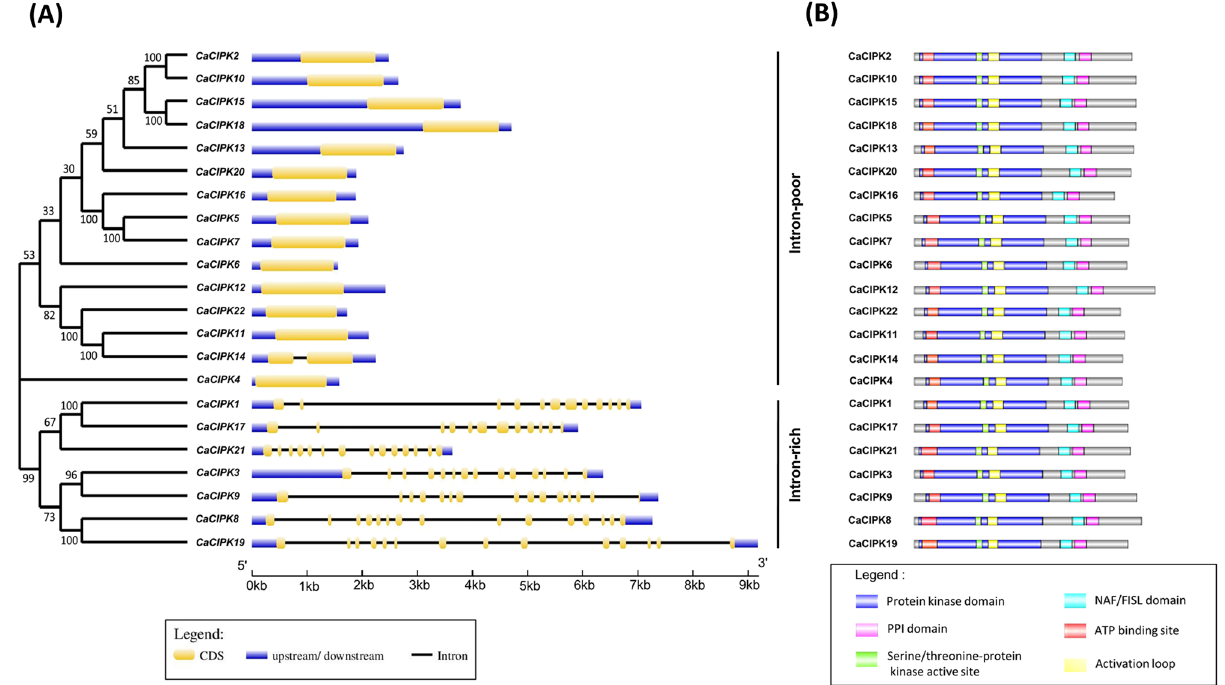
Figure 1. Structural features of chickpea CIPK family. ( A ) Exon–intron organization is shown for 22 CaCIPK genes. The gene structure was drawn using GSDS program. The yellow boxes represent exons, the lines represent introns and the blue boxes represent upstream/downstream UTRs. The values in the phylogenetic tree (left side) represent bootstrap values. ( B ) Protein structure of chickpea CIPK family showing conserved protein kinase, NAF and PPI domain along with some important sites present at the N-terminal e.g. ATP binding site, Serine/ threonine-protein kinase active site and activation